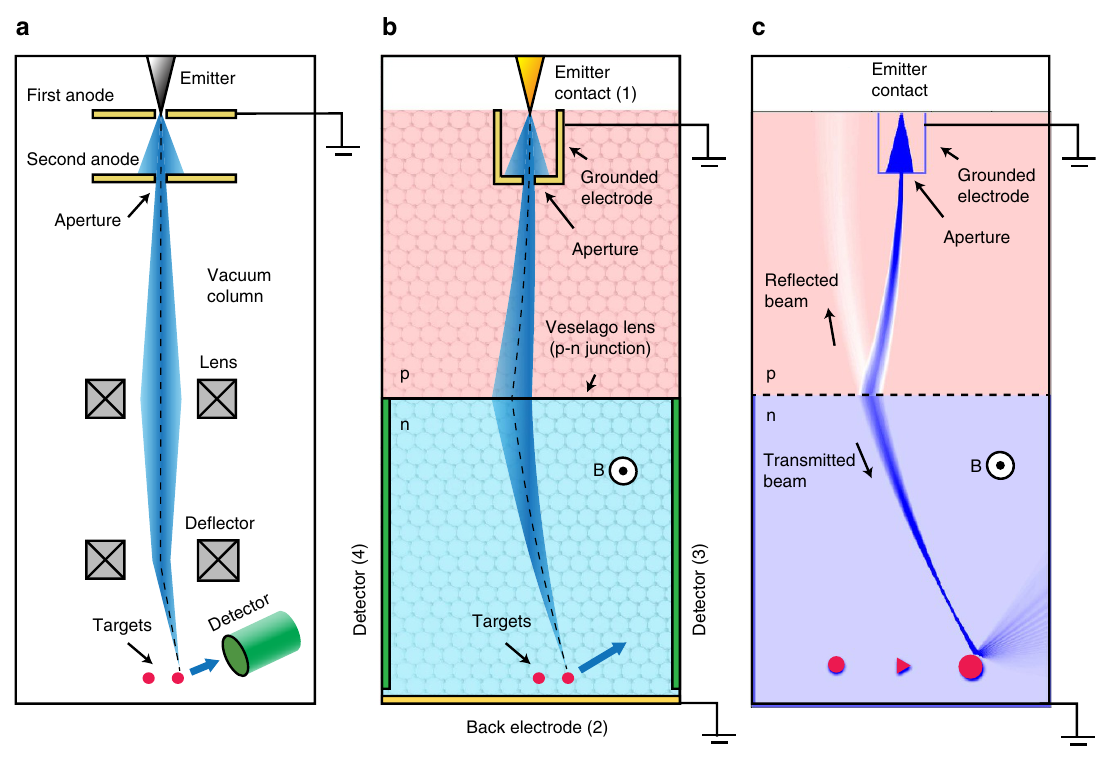
Figure 1 | Conventional SEM versus DFM. ( a ) Illustration of a SEM with the electrons travelling in straight lines inside a vacuum column, from the emitter, through an aperture and a set of lenses that focus the electrons into a sharp beam at the surface. A deflection lens directs the electrons to a specific spot on the surface, from which they scatter back and are measured by a detector. ( b ) The 2D equivalent is a graphene device, where a narrow metal contact or an opening plays the role of the electron emitter, while a p–n junction provides guiding/lensing of the electron trajectories. A back electrode (2) collects electrons that are not intercepted by a target. Backscattered electrons are picked up by side electrodes (3 and 4), allowing an image to be formed by measuring the transmission current. ( c ) Trajectory or current density from ballistic Monte Carlo simulation of a DFM, where carriers are injected from a point-like emitter contact (1), collimated by an aperture and focused by a symmetric p–n junction electron lens. Part of the beam is reflected from the p–n junction as indicated. The electron beam is seen to backscatter from one of the three targets, giving rise to a current flowing between electrodes 1 and 3, instead of 1 and